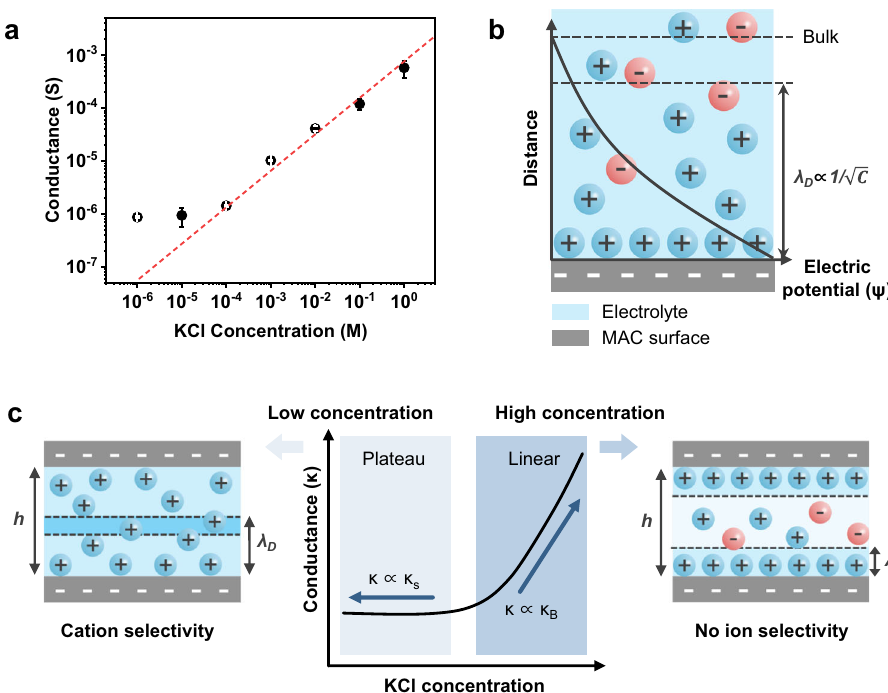
Fig. 3| Iontransport throughtheMACnanochannel.a Ionicconductanceofthe MACmembraneunderdifferentKClconcentrations. b SchematicofEDLformation on the negatively charged MAC surface. c Ion-transporting behavior under low concentrations of electrolyte ( h ~2 λ D ; left) and under high concentrations of elec- trolyte ( h » λ D ;right). Theionicconductance( κ )isthesum of bulkconductance( κ B )